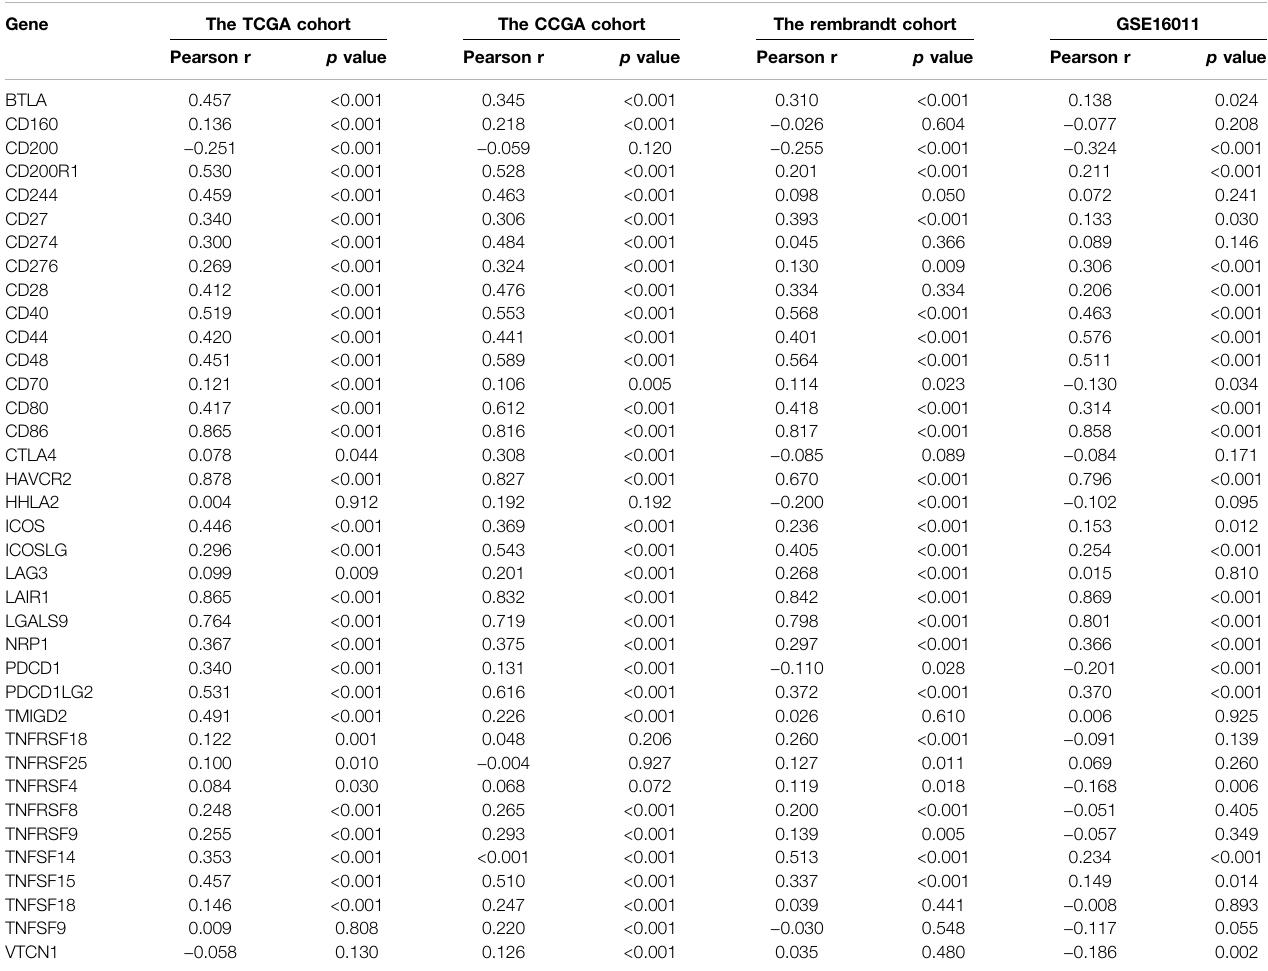
TABLE 1 | Correlation analysis between SYK expression and the mRNA expression of immune checkpoint markers in diffuse gliomas. Gene The TCGA cohort The CCGA cohort